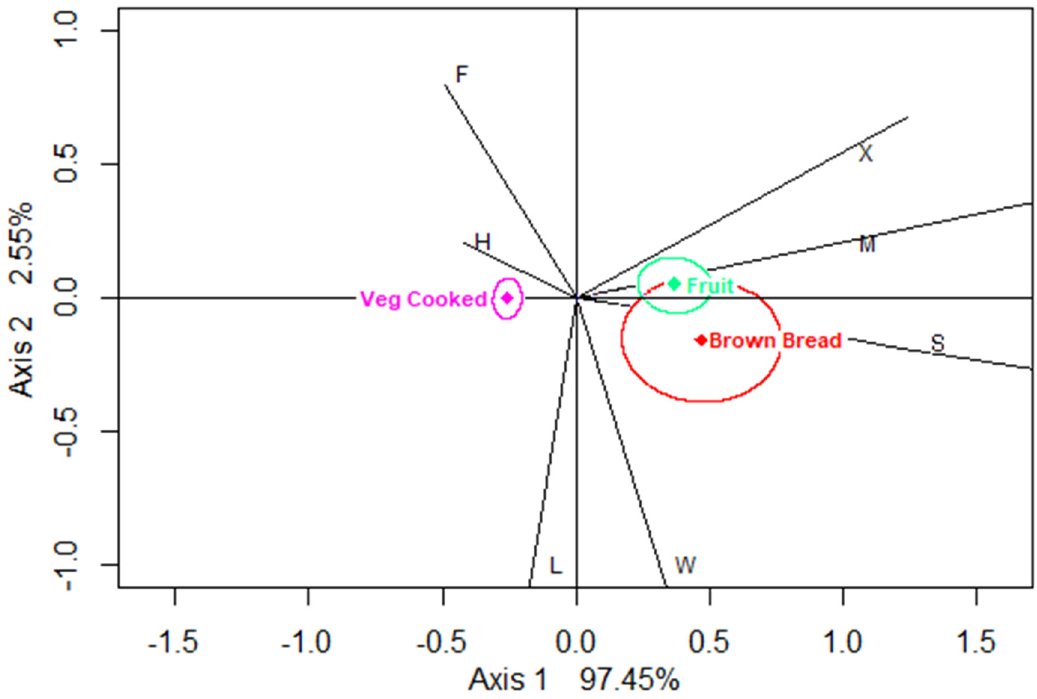
Figure 1. Biplot of locations showing confidence regions for healthier food groups (using